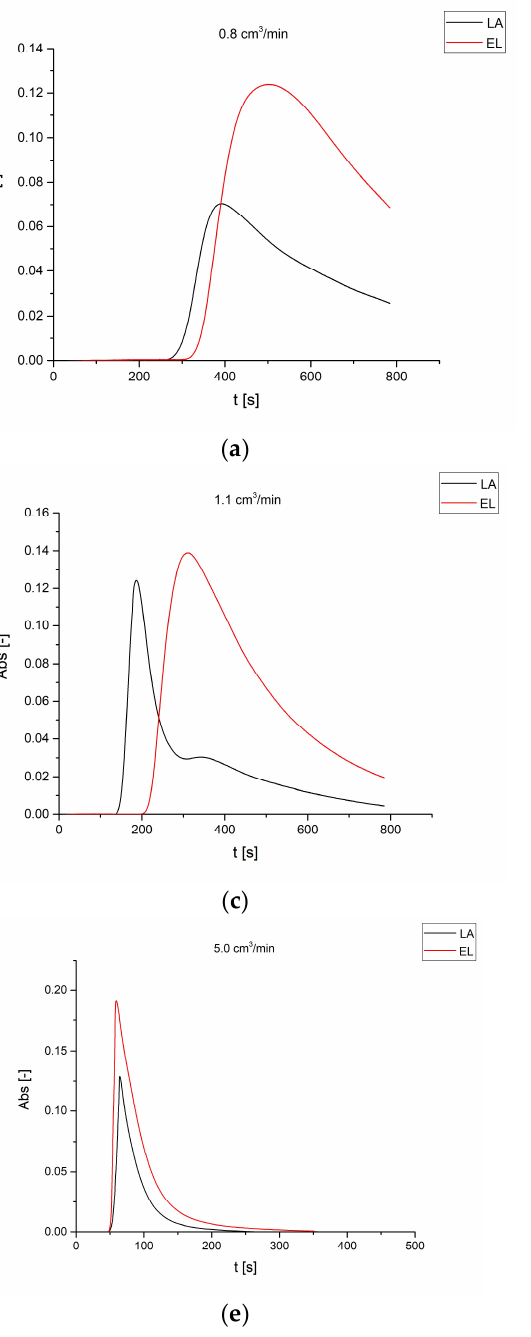
Figure 3. UV spectra of LA and EL 6 M at 303 K and different flow rates. ( a ) 0.8 cm 3 /min. ( b ) 0.9 cm 3 /min. ( c ) 1.1 cm 3 /min. ( d ) 2.5 cm 3 /min. ( e ) 5.0 cm 3 /min.